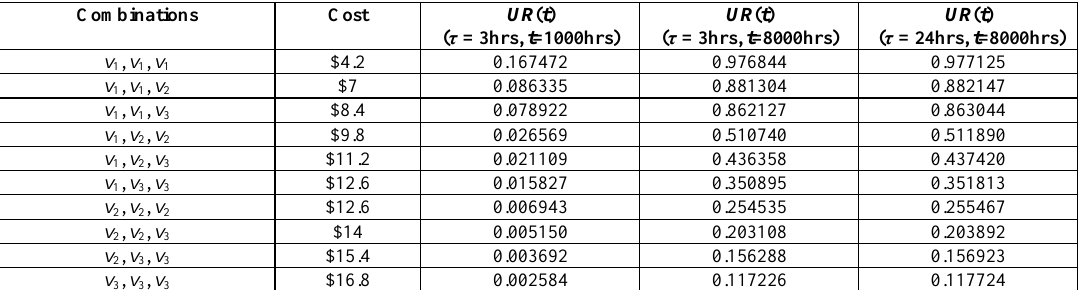
Table 2. Results of 2-out-of-3 with 3 cloud providers